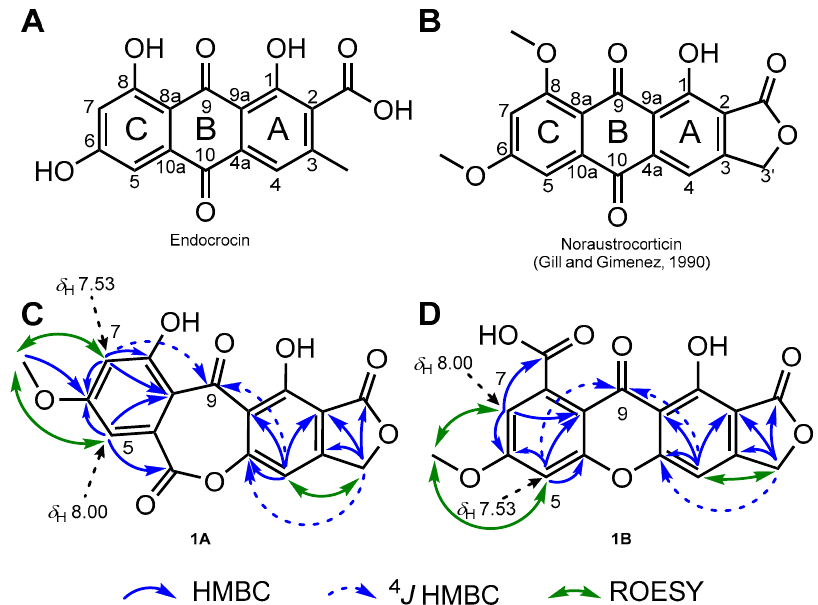
Figure 1. ( A ) Chemical structure of endocrocin, biosynthetic cornerstone of fungal polyketides. ( B ) Chemical structure of noraustrocorticin, anthraquinonic pigment reported from an unidentified Australian Cortinarius species. ( C ) Key 2D NMR correlations plotted on the oxepinedione-containing seco-anthraquinone scaffold hypothesis 1A . ( D ) Key 2D NMR correlations plotted on the xanthone scaffold hypothesis 1B .